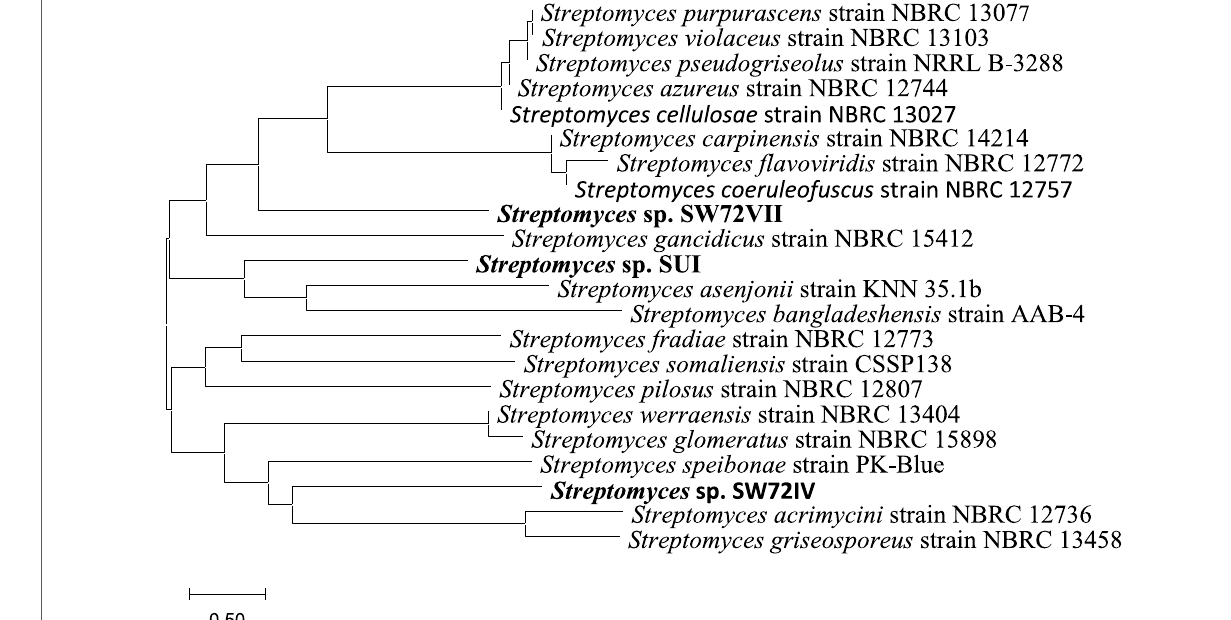
Fig. 1 Relatedness of Streptomyces sp. SUI, Streptomyces sp. SW72IV and Streptomyces sp. SW72VII with other strains of Streptomyces at NCBI